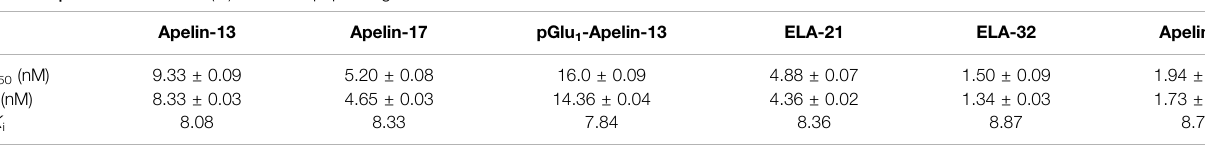
TABLE 1 | Inhibition constant (Ki) of the six peptide ligands.